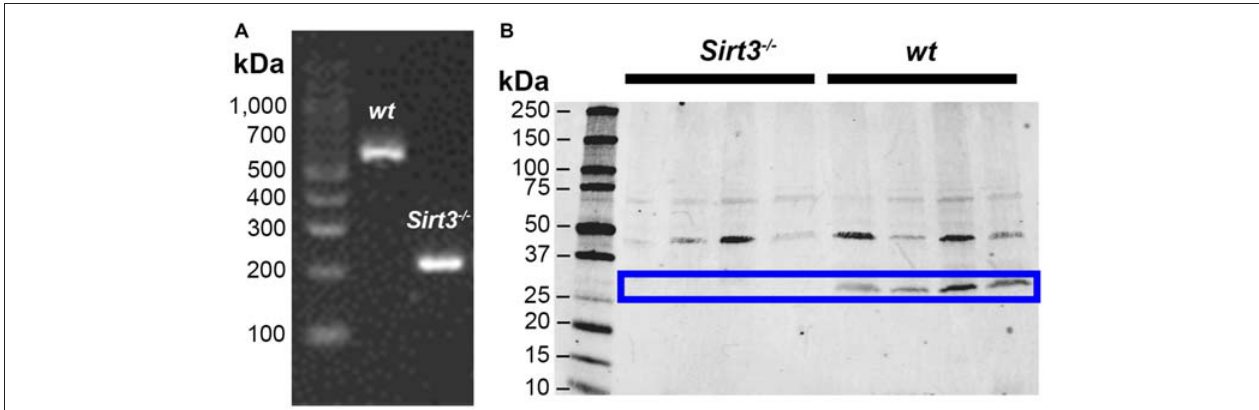
FIGURE 1 | Representative images showing detection of Sirt3 in the mouse colon by RT-PCR (A) and western blot (B) . Tissue from Sirt3 − / − mice was used as a negative control. PCR amplification of Sirt3 mRNA (A) shows the expected products at 562 bp for wt Sirt3 and 200 bp for mutant Sirt3 ( Sirt3 − / − ). Western blots for Sirt3 protein (B) show two bands potentially corresponding to the full-length nuclear protein at 44 kDa and the processed mitochondrial form at 28 kDa. However, only the band at 28 kDa is absent in Sirt3 − / − mice and this band corresponds to the single known form of mouse Sirt3.